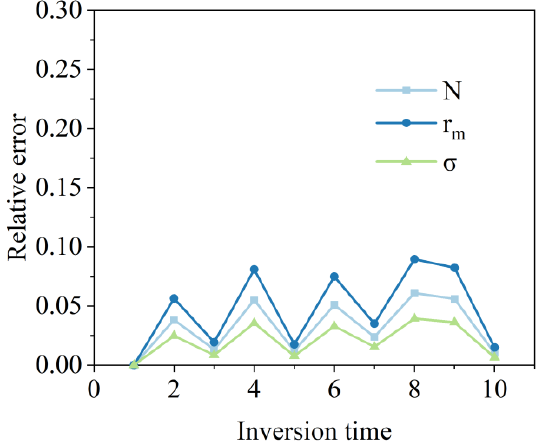
Figure 7. The relative error for different random initial values.